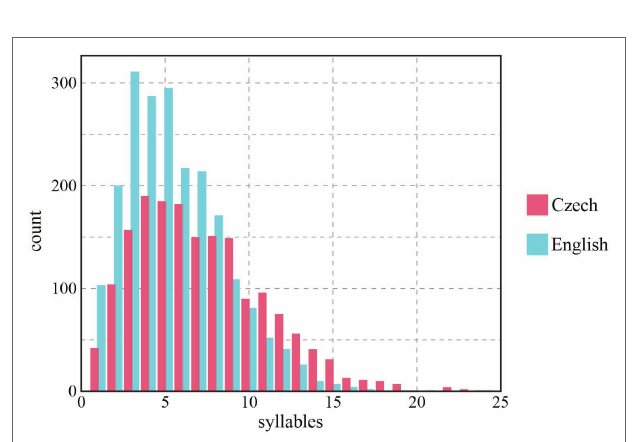
FIGURE 2 | Number of syllables (left) and words (right) per prosodic phrase depending on L anguage , only in BI4 phrases and with no disfluencies (BI4-d). *** p < 0.001.